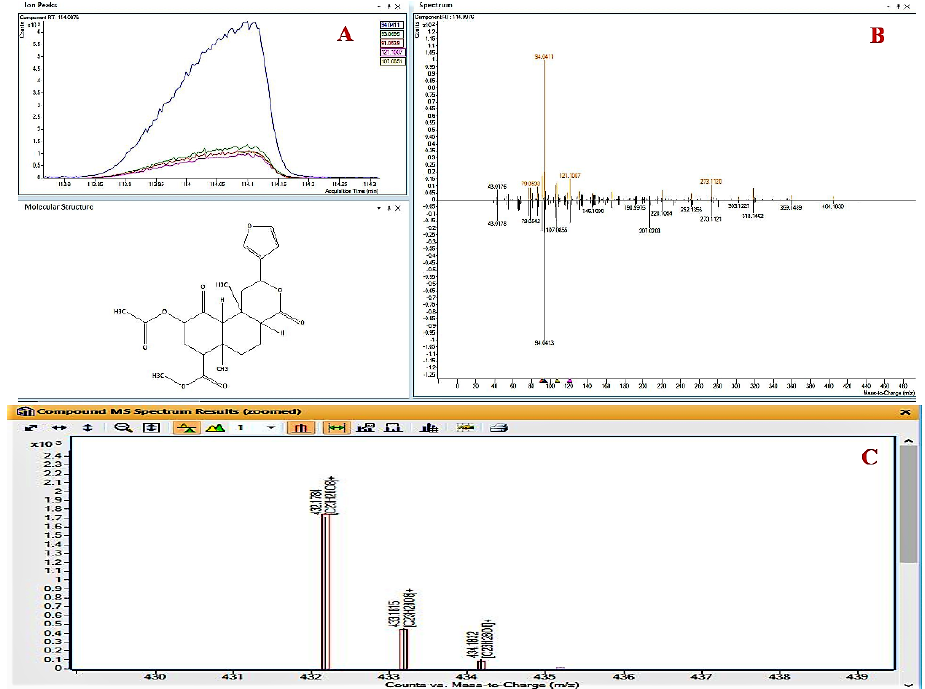
Figure 5. Identification of salvinorin A from S. divinorum (#22490). ( A ) Overlaid chromatograms of the five ions extracted for salvinorin A; ( B ) a “head-to-tail” comparison plot of high-resolution spectra of salvinorin A from PCDL (black) and the sample (orange); ( C ) the isotope pattern of the molecular ion (black vertical lines) compared to the theoretical pattern (red boxes).